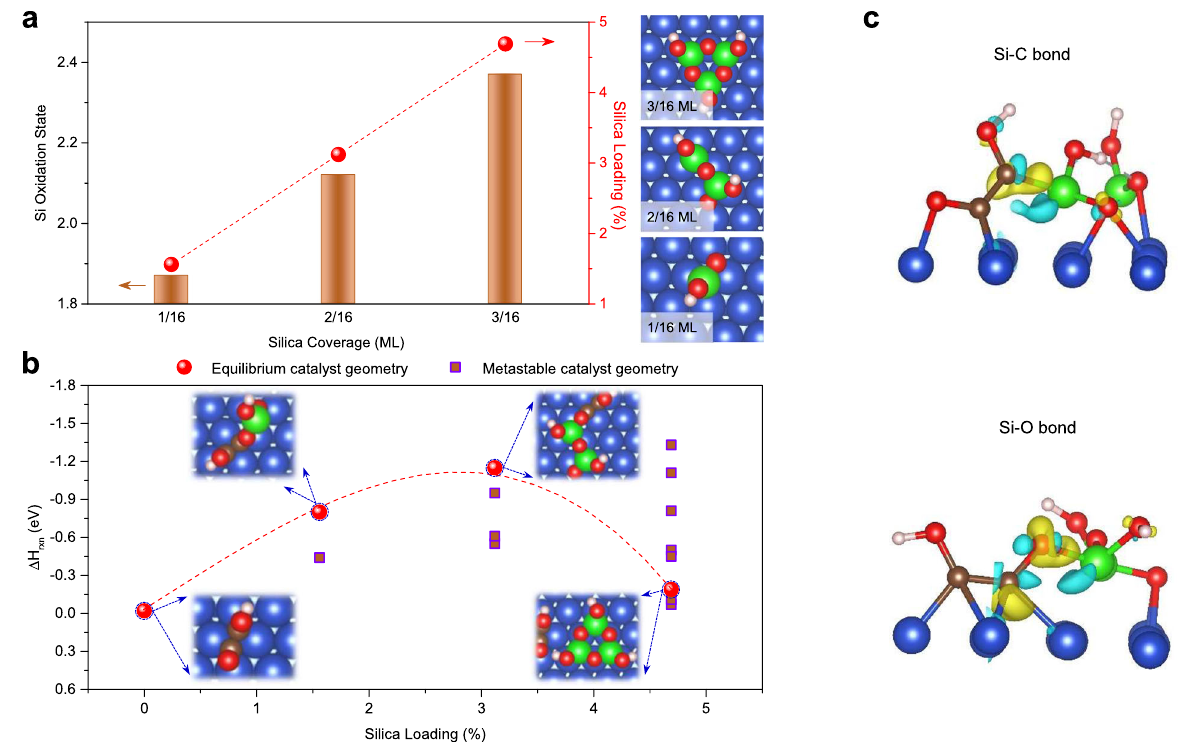
Fig. 1 DFT calculations. a The oxidation state of Si and silica loading as a function of silica coverage over Cu(111) at the energetically favorable catalyst geometries. b The formation energy ( 4 H rxn ) of OCCOH* (CO (cid:3) þ COH (cid:3) ! OCCOH (cid:3) ) over the pure Cu(111) and possible Cu-SiO x catalysts, including equilibrium (sphere) and metastable (square) catalyst geometries; A volcano-like plot is achieved for the formation energy of OCCOH* over the equilibrium Cu-SiO x catalyst geometries. c Differential charge density plots show the 3.1% silica-loaded Cu-SiO x step surface can stabilize OCCOH* adsorption by creating either Si – C or Si – O bonds and lower the formation energy of the OCCOH* intermediate. The iso-surface level of the differential charge densities is 0.012 e/bohr 3 . The yellow or blue areas represent a gain or loss of electrons. Color-coded atoms represent Cu (blue), Si (green), O (red), C (brown), and H